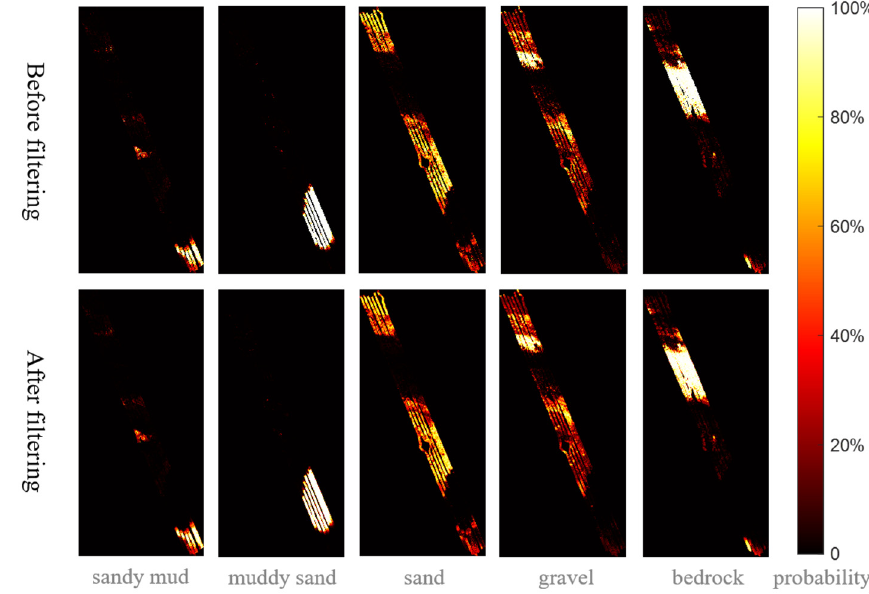
Figure 9. Probability maps before and after Gaussian filtering.